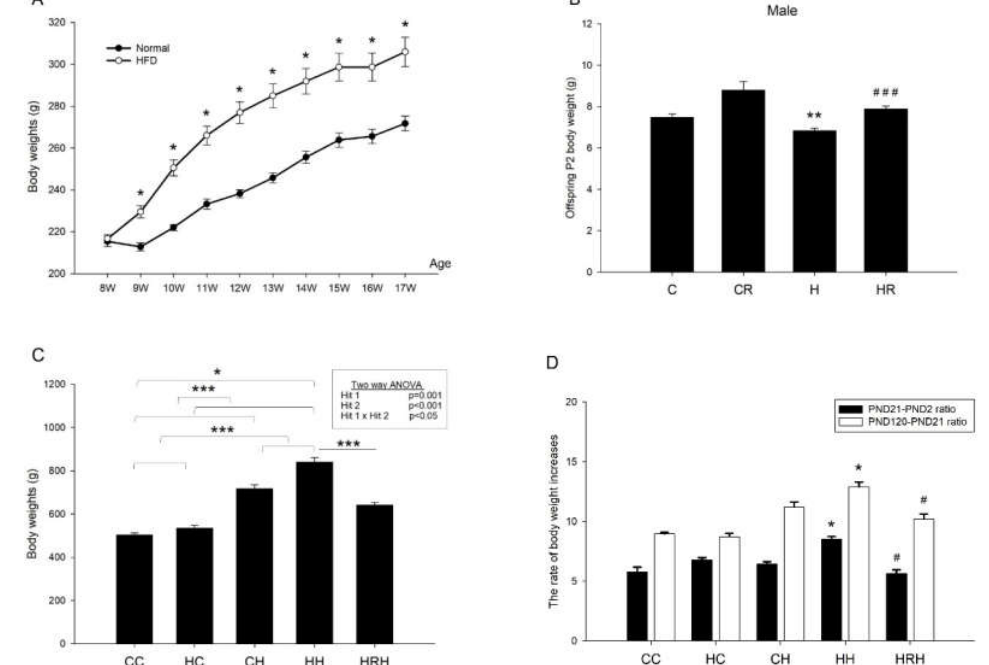
Figure 3. Body weight. ( A ) Female rats were fed a chow diet or a high-fat diet (HFD) and weighed weekly for 8 weeks before mating. n = 10–12 for each group. Student’s t -test, * p < 0.05 vs. HFD; ( B ) After mating, male pups were weighed on PND 2. F (3,92) = 16.075, p < 0.0001. n = 10–12 for each group. ** p < 0.01 vs. C; ### p < 0.001 vs. H. One-way ANOVA followed by Fisher’s LSD post hoc was